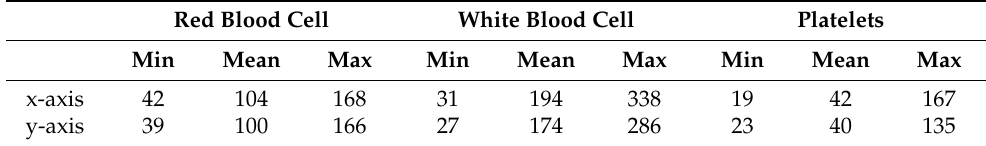
Table 2. Blood cell size information in